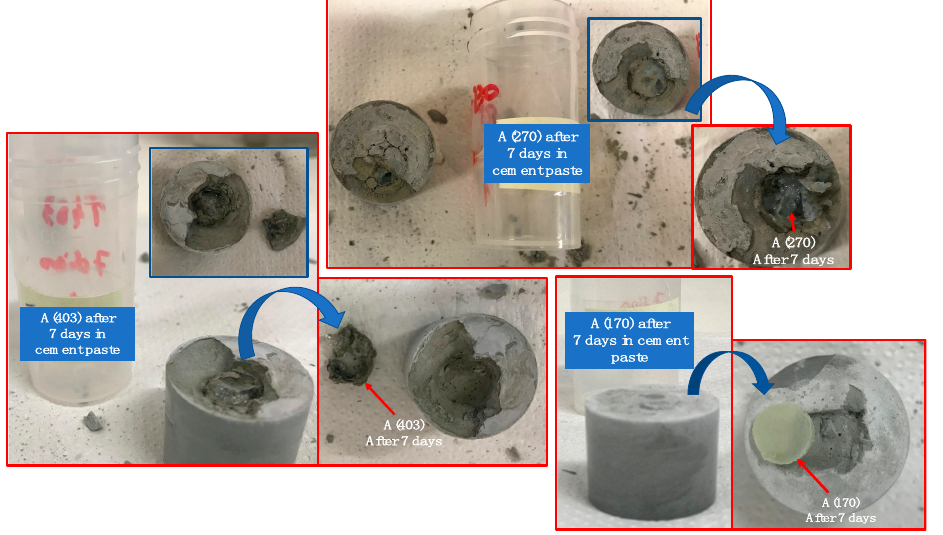
Figure 7. OIH samples (A(270), A(403), and A(170)) after 7 days immersed in cement paste with a w/c = 0.5.